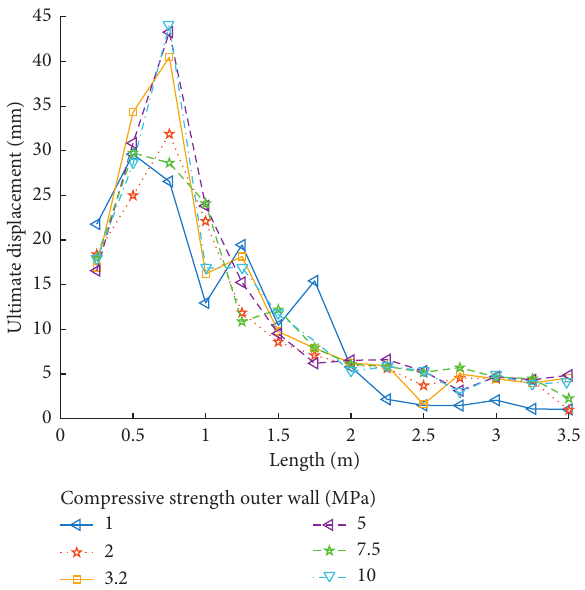
Figure 12: Ultimate force vs precompression ratio for different